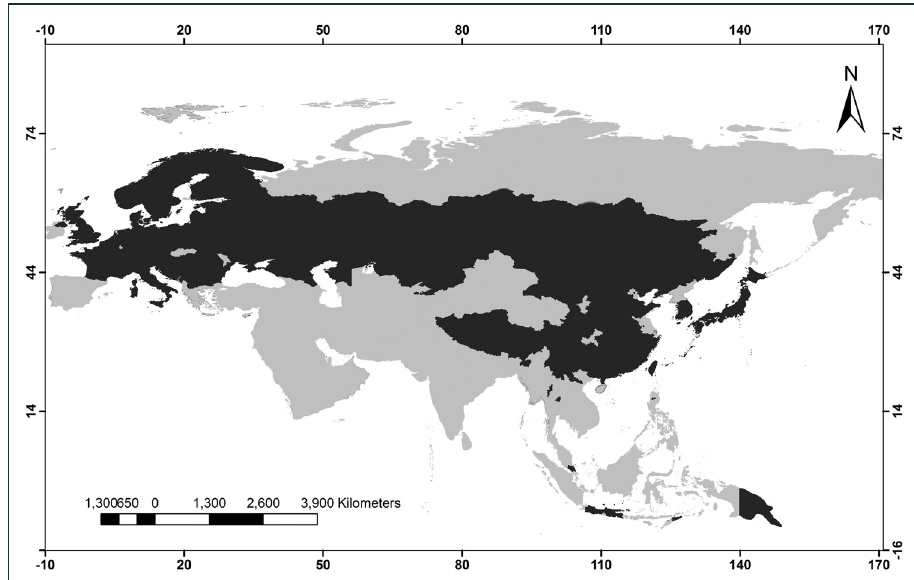
Figure 1. Geographical distribution of Herminium